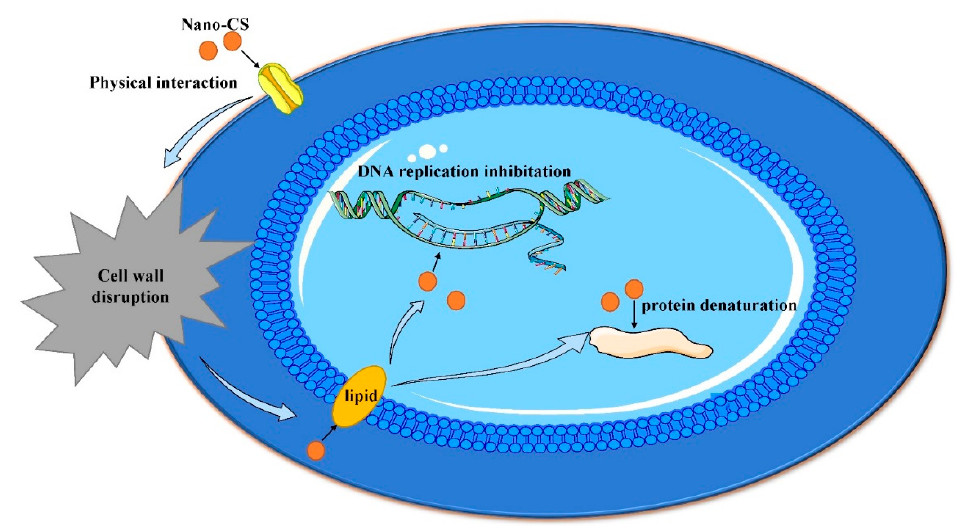
Figure 6. A schematic model of the antibacterial mechanism of nano-CS (Picture material cited from https://smart.servier.com/ (accessed on 10 September 2021). https://smart.servier.com/ (accessed on 10 September